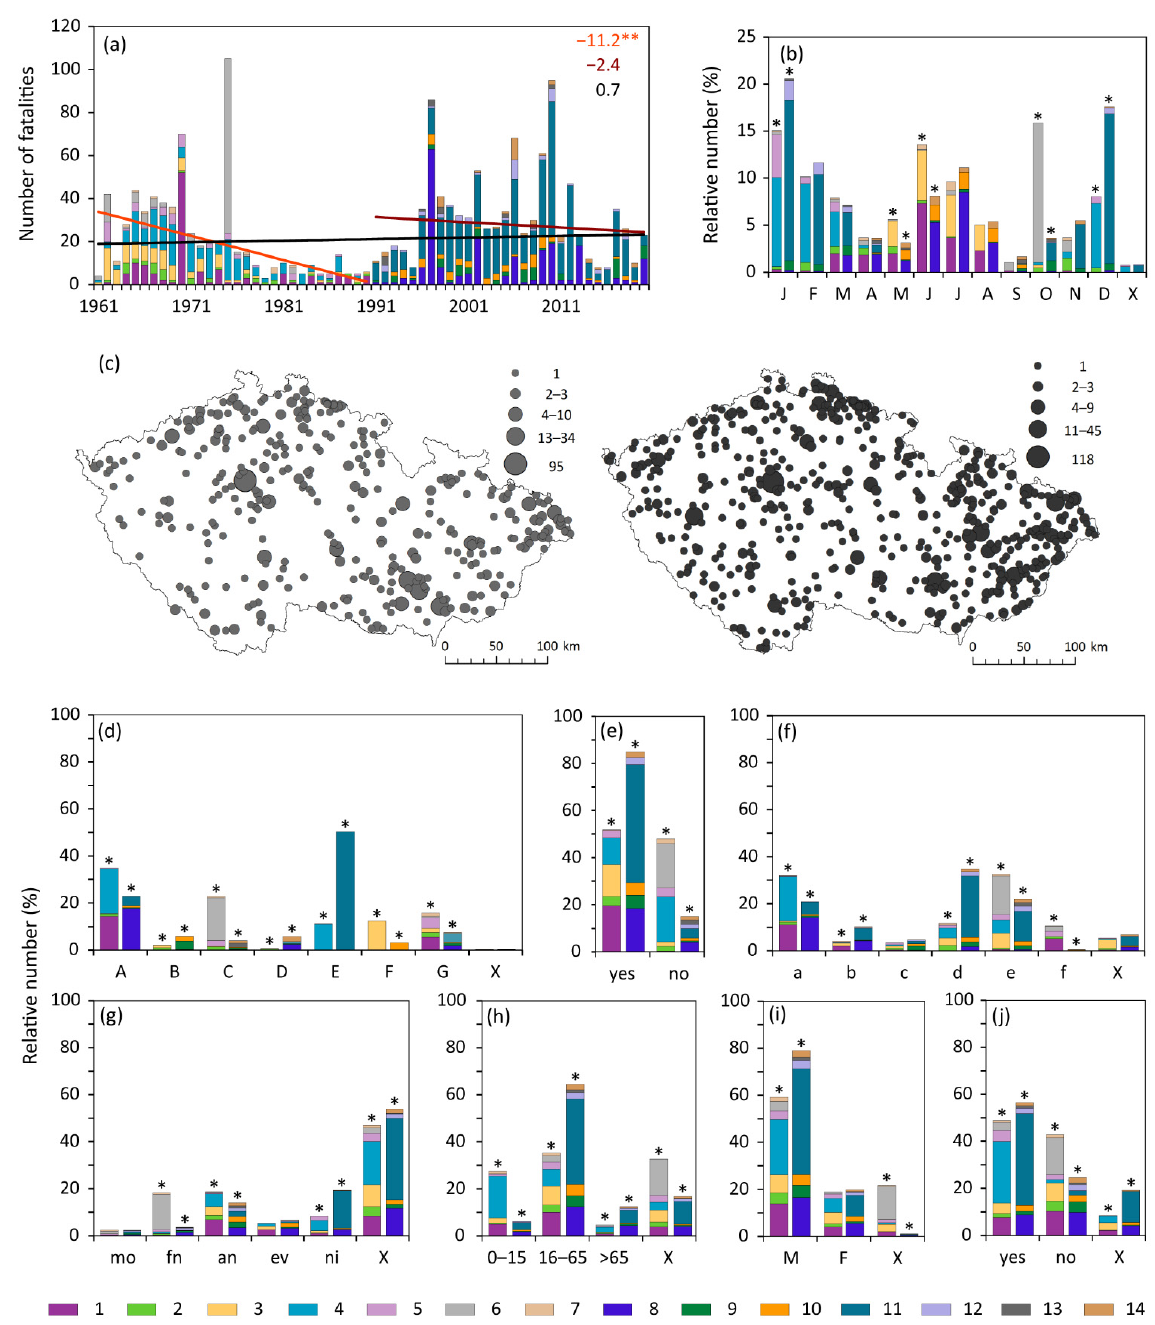
Figure 7. Characteristics of weather-related fatalities (1, 8—flood, 2, 9—windstorm, 3, 10—convective storm, 4, 11—snow and glaze ice, 5, 12—frost, 6, 13—fog, 7, 14—other severe weather) in the Czech Republic during the 1961–1990 and 1991–2020 periods. ( a ) Fluctuations with linear trends (top right in fatalities/10 years for both 30 years and 1961–2020, trends with ** are significant for p < 0.05); ( b ) annual variation; ( c ) spatial distribution (36 fatalities in 1961–1990 and 18 fatalities in 1991–2020 lack exact location); ( d ) cause of death; ( e ) type of fatality (direct); ( f ) place of death; ( g ) time of day; ( h ) age; ( i ) gender; ( j ) behaviour (hazardous). For an explanation of symbols and abbreviations see Figure 2.